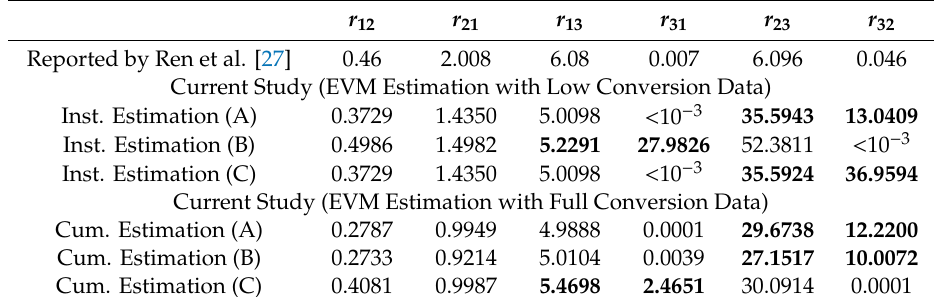
Table 2. Reactivity ratio estimates for the terpolymerization of BA / BMA / lim with experimental data from Ren et al. [27]. r 12 r 21 r